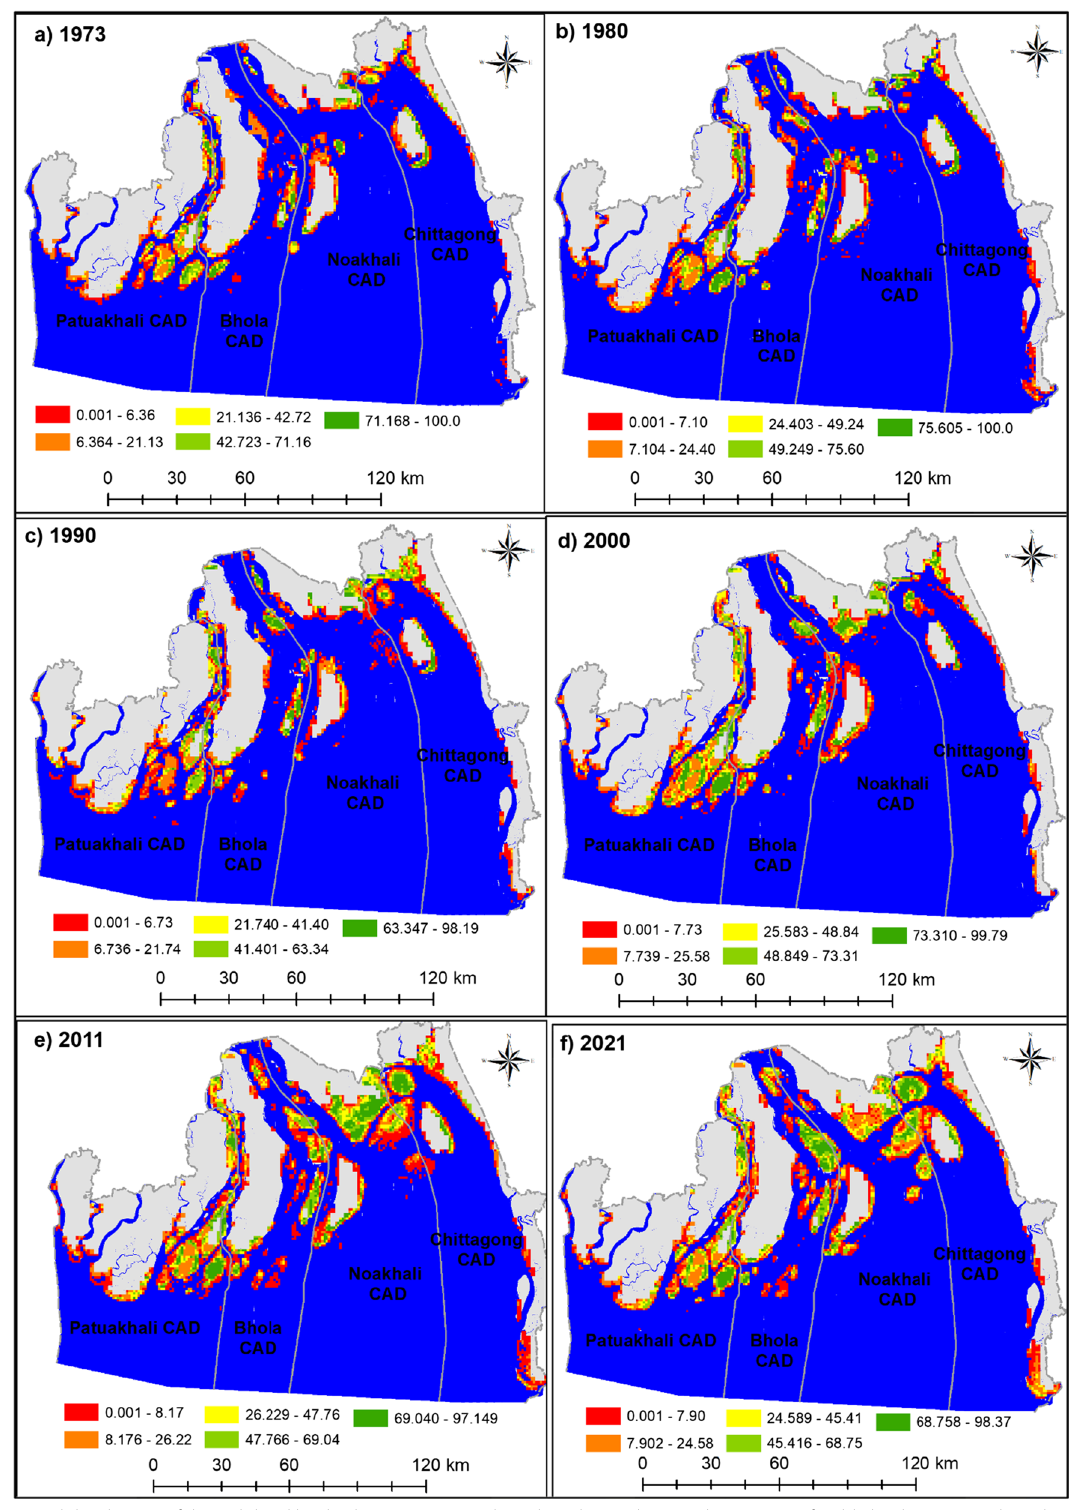
Fig. 9 Spatial distribution of the stabilized land in ha (1962–2021). The color scheme denotes the amount of stable land portion within 1 km